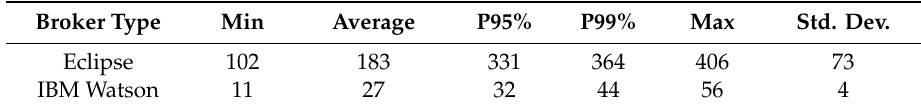
Table 4. Statistics of the D CS (Delay from Cloud user application to Subscriber) collected in the experiments. All values are in